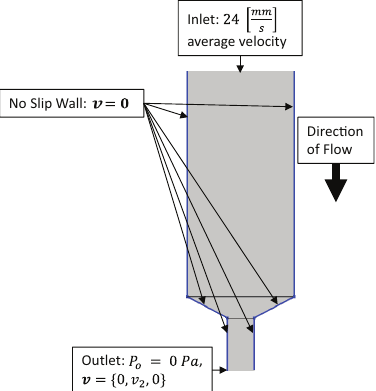
Figure 2. The flow domain of the nozzle alone with boundary conditions. (Nozzle dimensions are the same as those shown in Figure